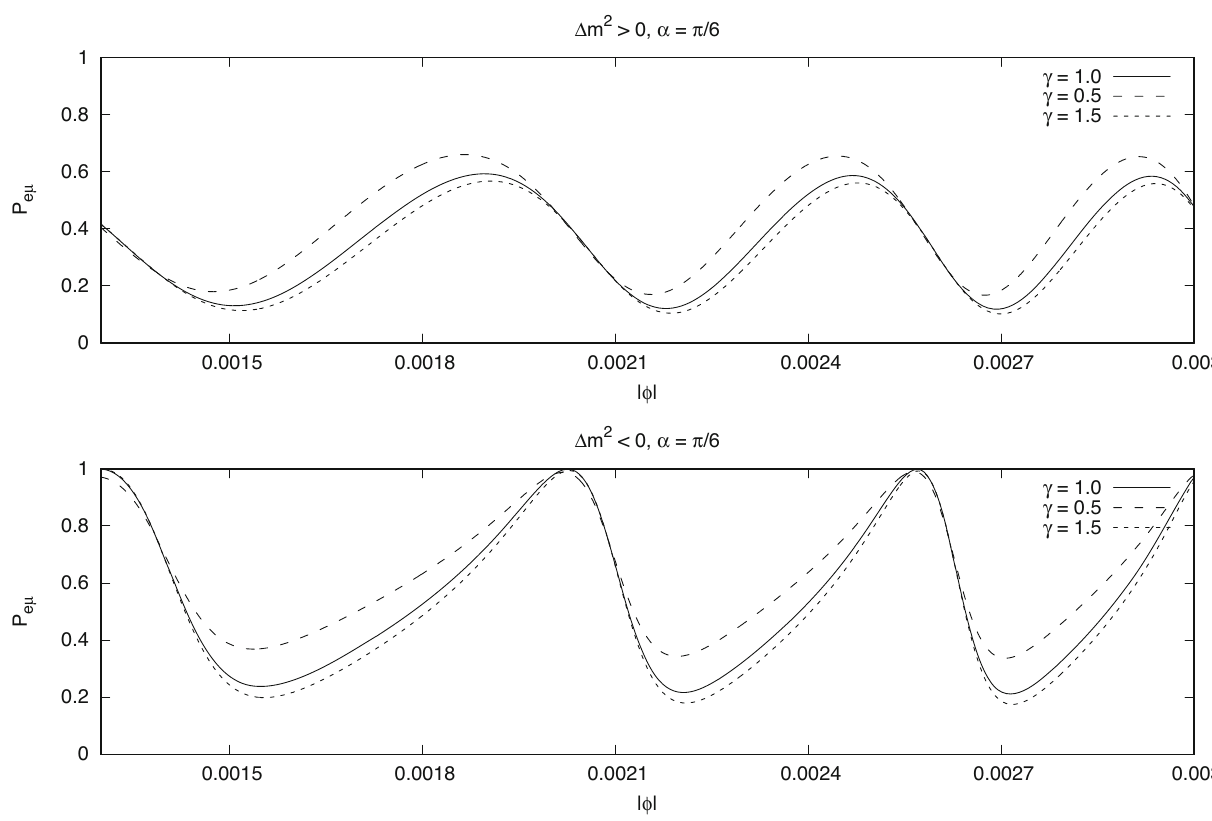
Fig. 3 Top panel: neutrino oscillation probability as a function of azimuthal angle φ for γ = 1 . 0 (solid line), γ = 0 . 5 (dashed line) and γ = 1 . 5 (dotted line) for normal hierarchy (cid:8) m 2 > 0. Bottom panel: neutrino oscillation probability for γ = 1 . 0 (solid line), γ = 0 . 5